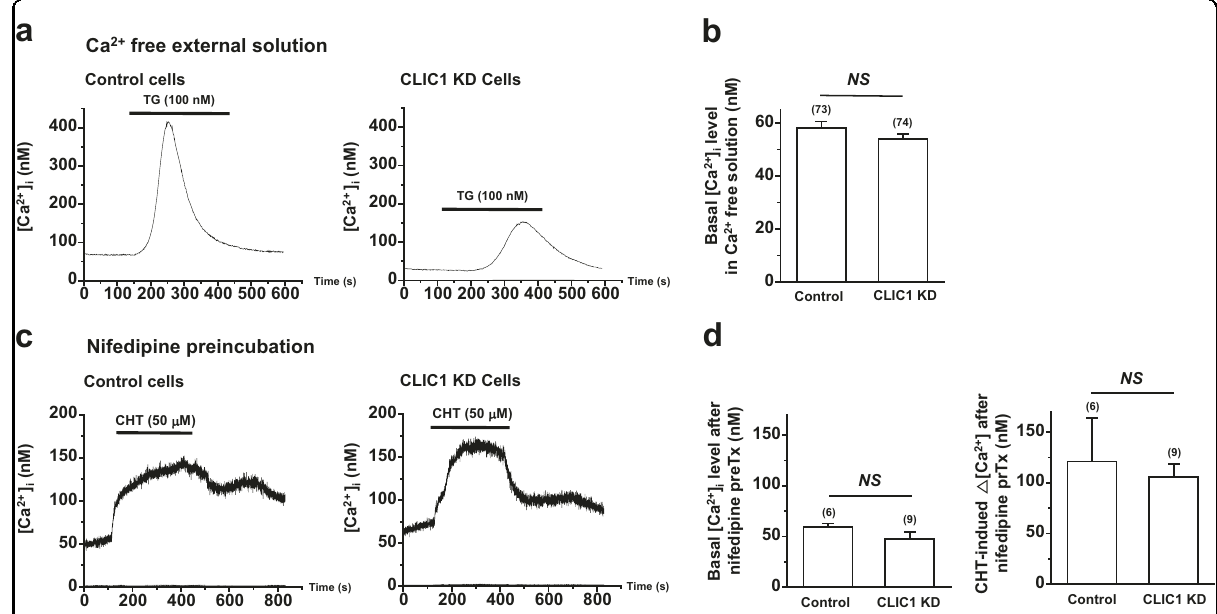
Fig. 6 Suppression of extracellular Ca 2 + or treatment with nifedipine inhibited the CLIC1 knockdown-induced increase in [Ca 2 + ] i in A549 cells. a Time-dependent measurement of [Ca 2 + ] i in control cells (left) and CLIC1 KD cells (right) after incubation in Ca 2 + -free medium for 45 min. b Quanti fi cation of the basal [Ca 2 + ] i (left) and TG-induced Δ [Ca 2 + ] i (right), as shown in ( a ). P -values were determined by Student ’ s t -test, and the data are expressed as the means ± SEMs. c Time-dependent measurement of [Ca 2 + ] i in control cells (left) and CLIC1 KD cells (right) after pretreatment with 10 μ M nifedipine, an L-type Ca 2 + channel blocker, for 24 h. d Histograms showing the effect of nifedipine on the basal [Ca 2 + ] i (left) and chelerythrine- induced Δ [Ca 2 + ] i (right), as shown in ( c ). P -values were determined by Student ’ s t -test, and the values shown are the means ± SEMs. NS